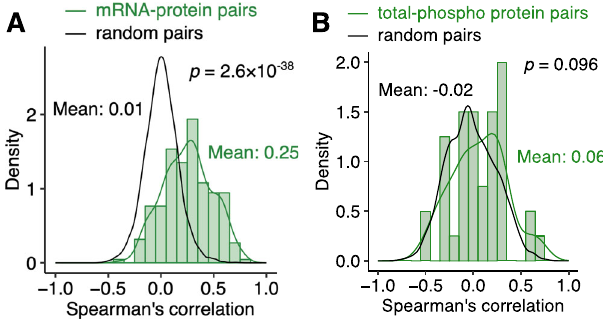
Fig. 1 | Correlation between expression levels of mRNA, protein, and phopho- proteins in 259 primary liver cancers. A Spearman ’ s correlation of expression levels in 222 mRNA-protein pairs are shown in green. Correlation in 22,200 ran- domly shuf fl ed pairs are shown in black. B Correlation in 40 pairs of total and phosphorylated proteins are shown in green. Correlations in 4000 random pairs areshowninblack.Statisticalsigni fi cancewasassessedusingtwo-sidedStudent ’ s t - test. Source data are provided as a Source Data fi